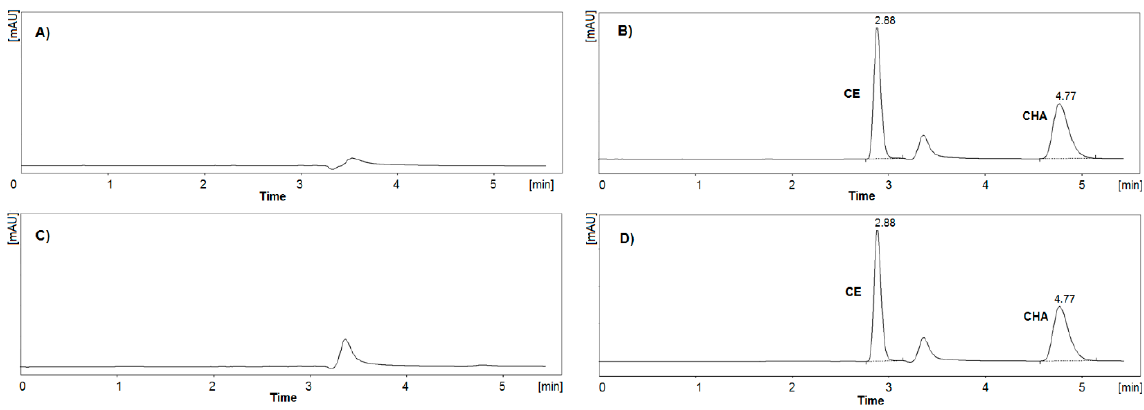
Figure 2. Chromatograms of: ( A ) Diluent, ( B ) STD, ( C ) placebo, ( D ) spiked sample .